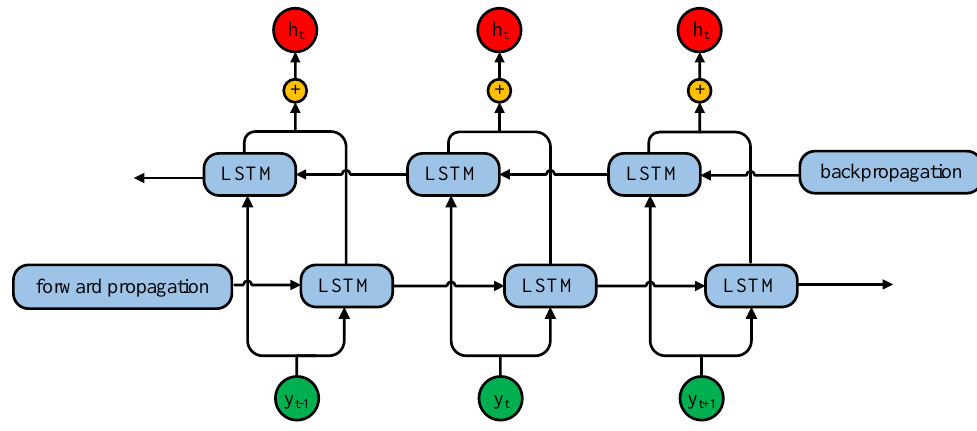
Figure 3. Recurrent unit structure of BiLSTM networks.